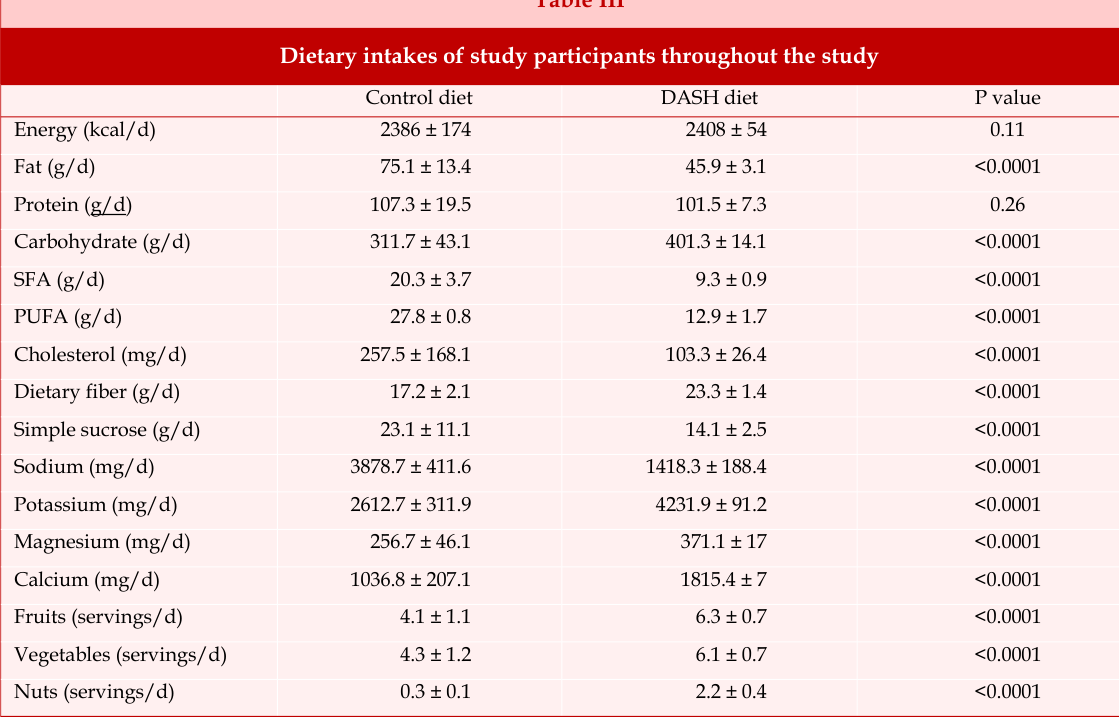
Dietary intakes of study participants throughout the